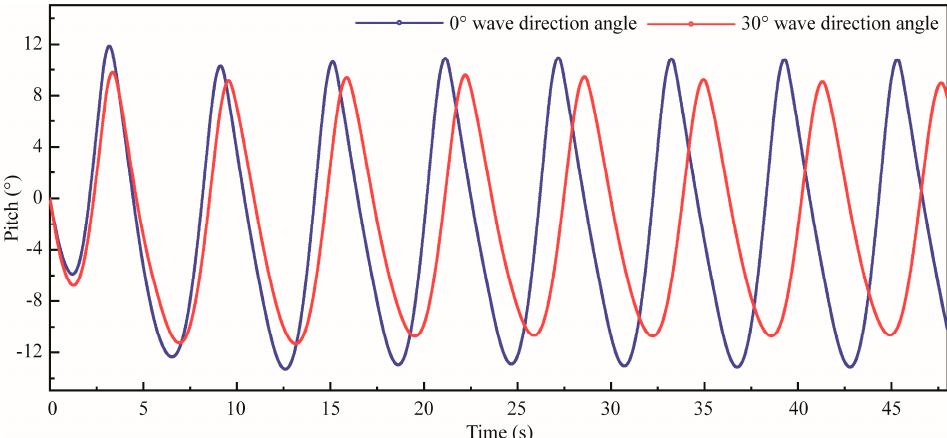
Figure 14. The pitch motion with different wave direction angles at 7 level sea state.